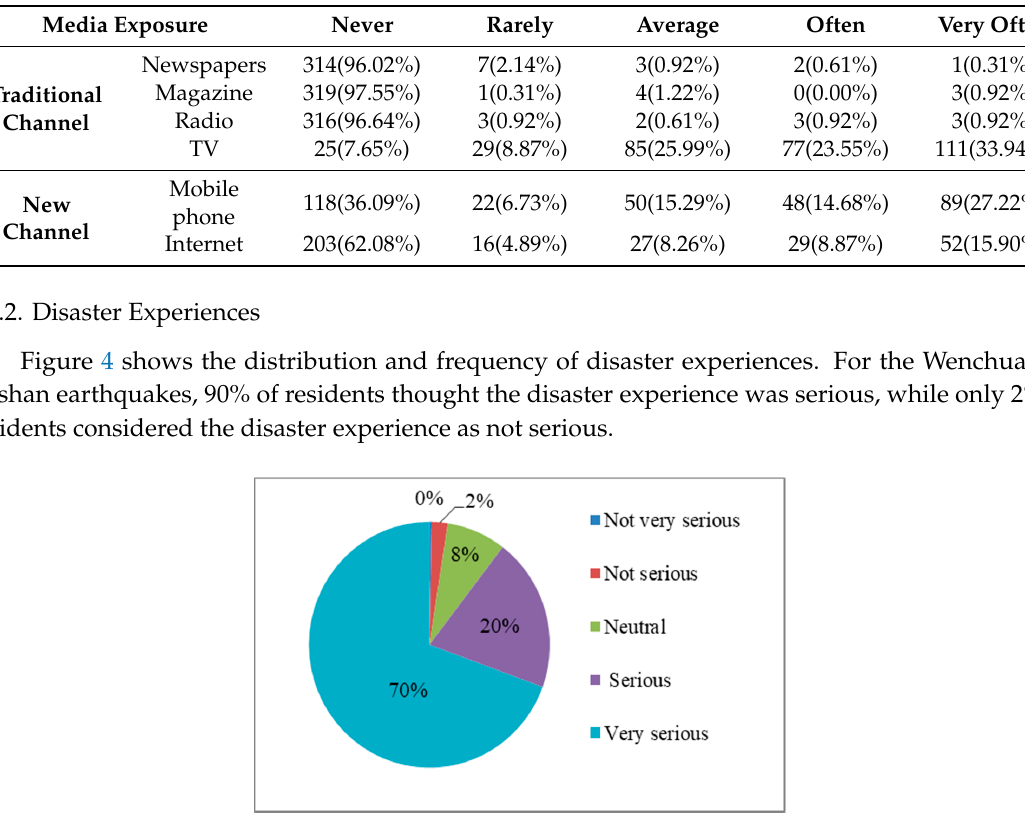
Figure 6. Another major earthquake will seriously affect residents’ lives and safety of property. 4.1.4. Control Variables As shown in Table 1, 54% of the respondents were men, the average age was 53.4 years, the average length of education was 6.29 years, and the most common occupation was farming (57%). The average cash income of the respondents’ families was 66,239 Yuan. Almost half of households (48%) included people over 64 years old, while nearly a quarter (24%) included children under 6 years old. Almost half of the households surveyed lived in houses that were constructed of concrete (48%). 4.2. Correlation Analysis Among Independent Variables Table 3 shows the correlation coefficient matrix of the model variables. The correlation coefficient of each independent variable in the model was essentially below 0.5; therefore, there was no significant multicollinearity between the independent variables of the model. With regards to the correlation among media exposure, disaster experience and the perceived prospect ranks of the probability and severity of disasters, the perceived prospect rank of the probability of disasters was significantly negatively correlated with new media exposure and disaster experience, but not with traditional media exposure. The perceived prospect rank of the severity of disasters was significantly and positively correlated with traditional media exposure, while it was not significantly correlated with new media exposure. Previous studies primarily focused on the correlation between core independent variables and dependent variables and did not control for other variables. The control of other variables, and making correlations between core independent variables and dependent variables, requires further analysis.